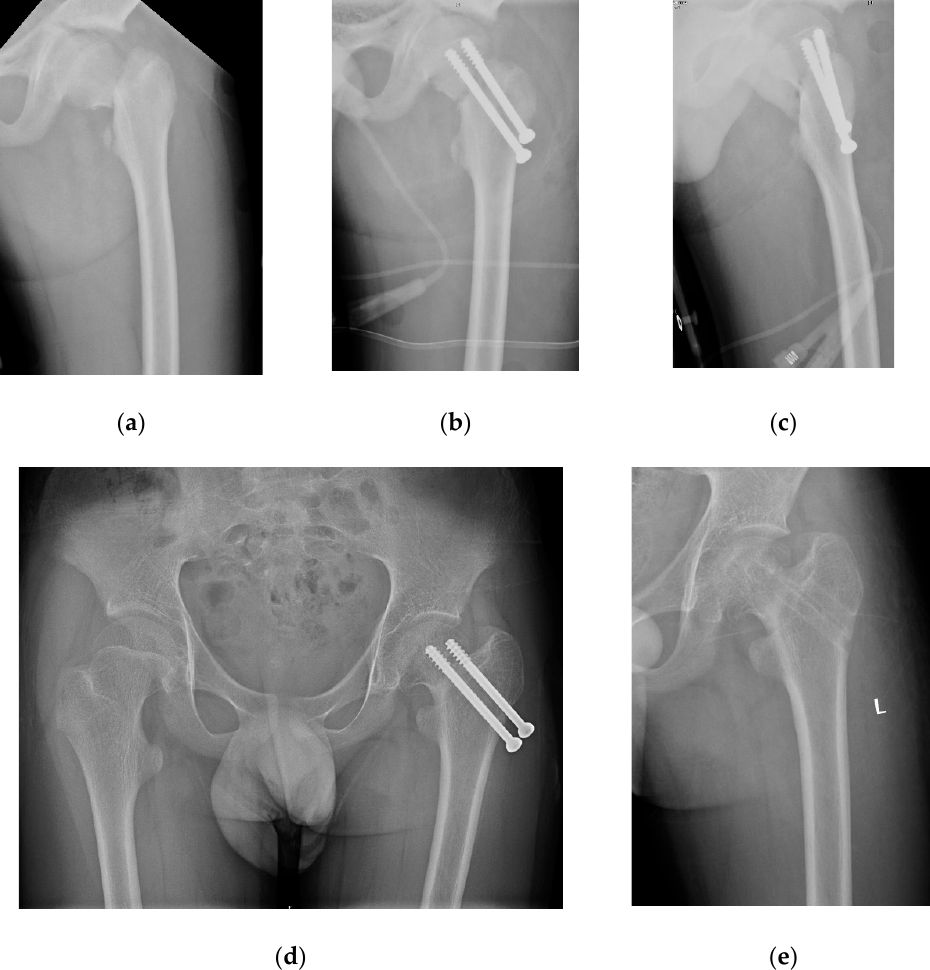
Figure 3. A 13-year-old boy with left FNF treated by 2 CCS. ( a ) Preoperative radiographs showed Delbet-II, Pauwels-III fracture; ( b,c ) postoperative radiographs; ( d ) outcome at 18 months postopera- tion; ( e ) unplanned hardware